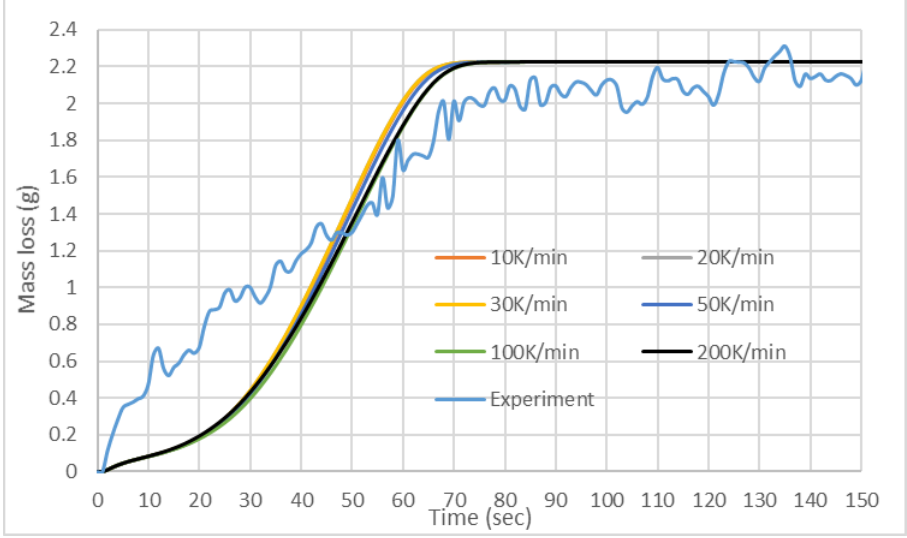
Figure 8. Mass loss results for the cone calorimeter tests with wool.